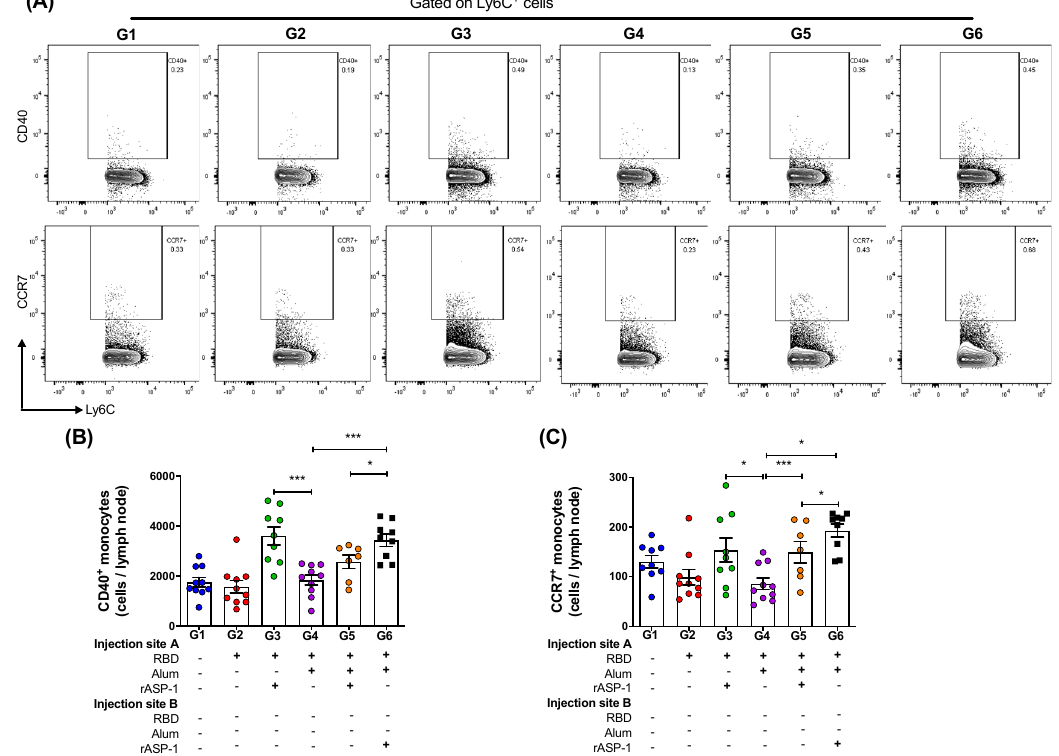
Figure 3. Monocyte subsets in the lymph nodes (LNs) of immunized mice: C57BL/6 mice were immunized i.m. with MERS-RBD-Fd with or without alum and rASP-1 alone or together using different combinations and/or formulations (Table 1 and X-axis legend). The draining LNs were harvested 7 days post-2nd immunization and the number of cells per LN were analyzed. (A) Representative flow cytometry plot of CD40 + monocytes (upper panel) and CCR7 + monocytes (lower panel in each immunization group. (B) The number of CD40 + monocytes, and (C) CCR7 + monocytes per LN were analyzed. The experiment was done once, and the data presented is from left and right draining LNs of 5 mice per group: mean and standard error. “+” indicates the presence and “ − “ indicates the absence of the protein or adjuvants in the formulation. Statistics was performed using one-way ANOVA with Tukey’s multiple comparison. p < 0.05: *, p < 0.001: ***.